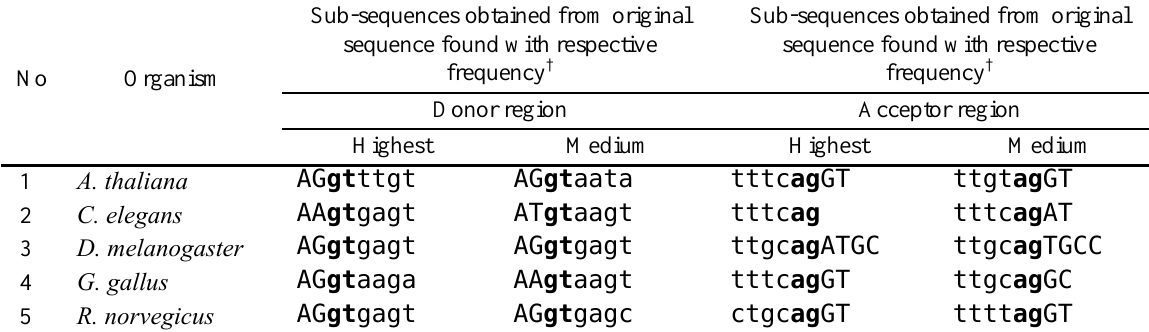
) 0 / 3 . nd / c - n y - b s / e s en c li g / o r s . on